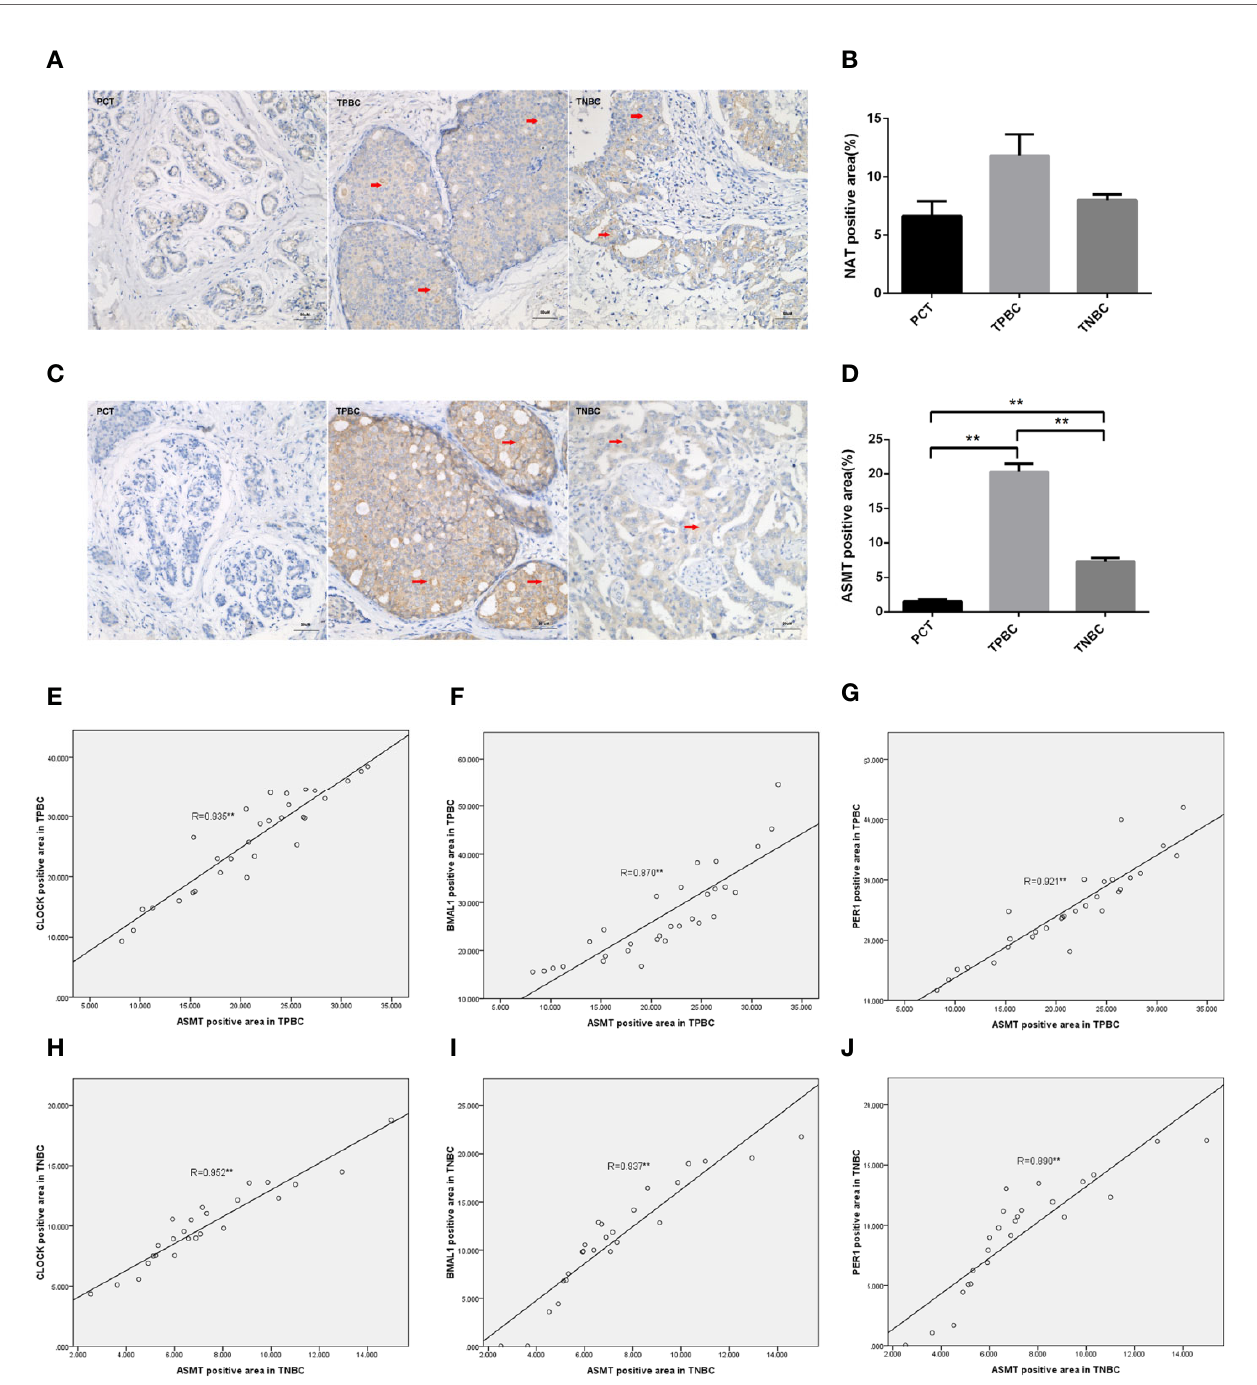
FIGURE 2 | Correlations between ASMT and the circadian clock system in TPBC and TNBC patients. Immunostaining analysis using antibodies against NAT (A) and ASMT (C) on tumor sections and PCT. The nuclei were stained with Hematoxylin (blue). Red arrows were used to indicate the positive area. (B, D) Quanti fi cation of NAT and ASMT positive areas relative to total areas. Data are the mean ± SEM (TPBC,n = 30;TNBC,n=25;PCT,n=8). **p < 0.01. (E – G) Correlations between ASMT expression and CLOCK, BMAL1, and PER1 expressions in TPBC. (H – J) Correlations between ASMT expression and CLOCK, BMAL1, and PER1 expressions in TNBC. The correlation analysis was performed by the Pearson ’ s correlation test, ** p <